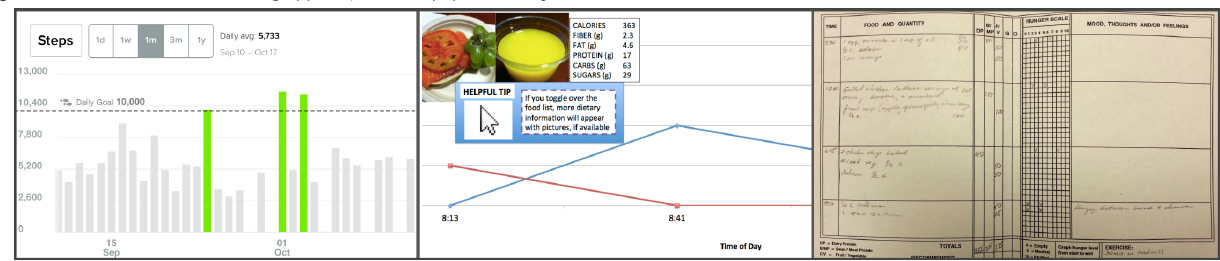
Figure 1. Patient-collected life-log apps (a, b) and a paper-based journal (c).